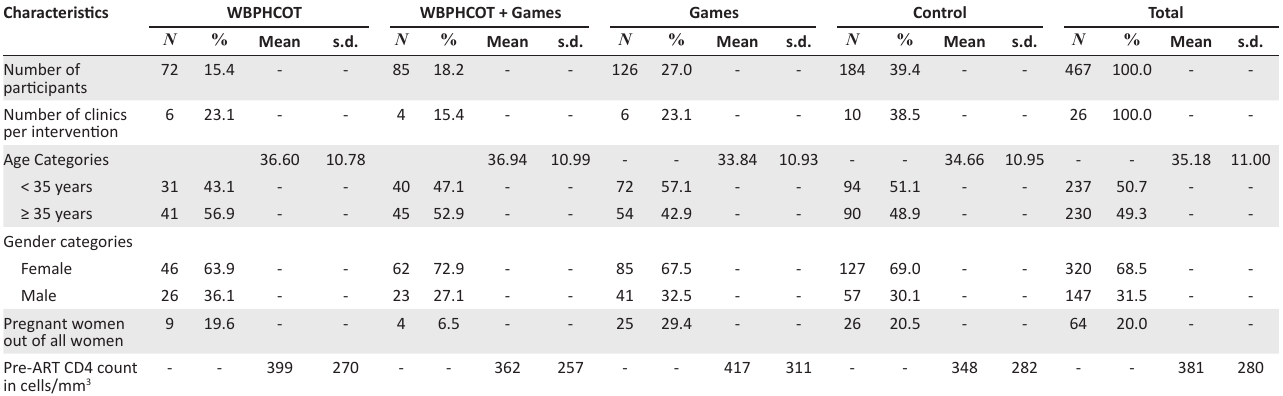
TABLE 1: Characteristics of